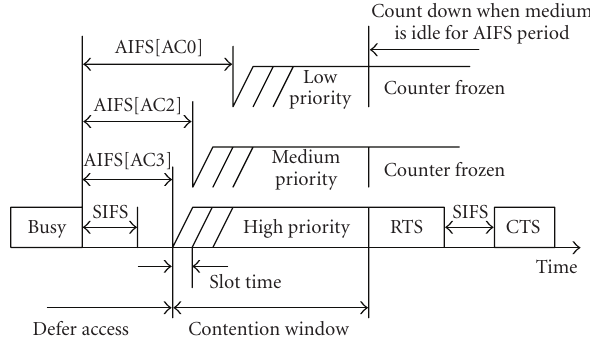
Figure 1: IEEE 802.11e EDCA mechanism parameters.